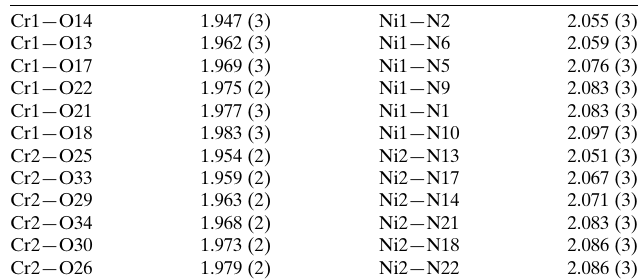
Table 1 Selected bond lengths (A˚ ).